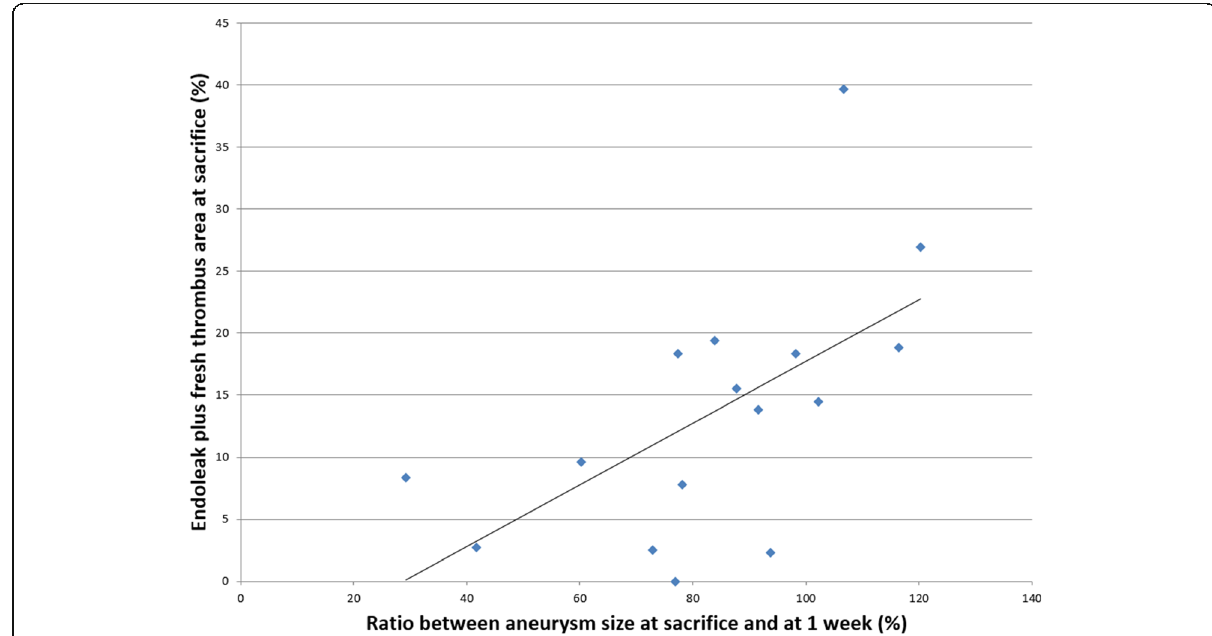
Fig. 3 Evolution of aneurysm size as a function of endoleak and fresh thrombus areas at sacrifice. Pearson coefficient r = 0.646, p =